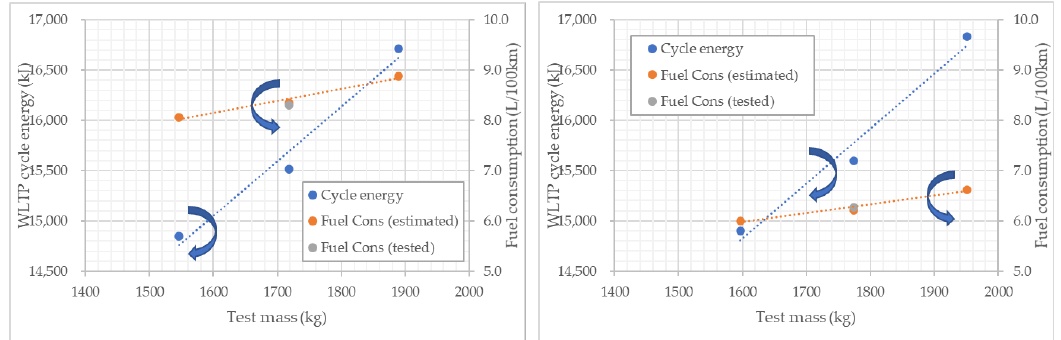
Figure 18. Effect of the test mass on the energy and fuel consumption in WLTP (left/right: gasoline/diesel) .